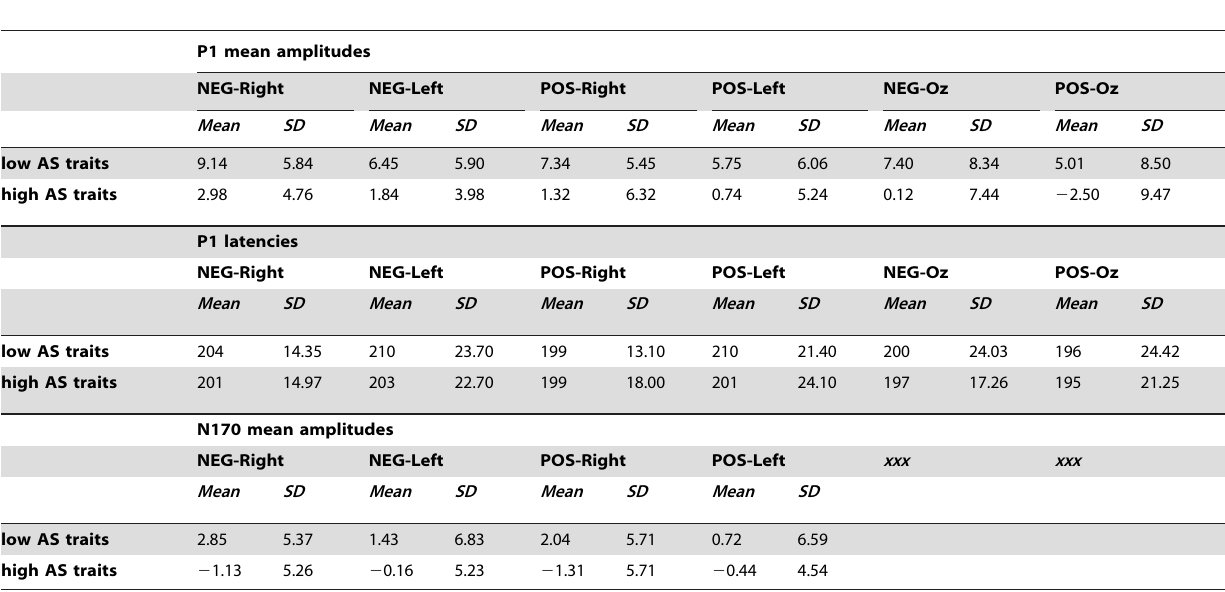
Table 1. Condition-wise (NEG – angry faces; POS – happy faces) averaged mean P1 and N170 amplitudes and standard deviation (SD) for face presentation on the right and left hemisphere and at Oz for participants high and low on antisocial traits (AS